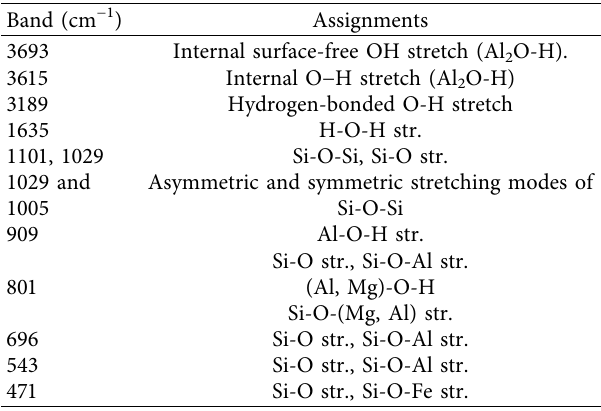
Figure 10: DRIFT spectra of dispersed phase of iron ore slime: (a) DPAD200, (b) DPHU8, and (c) Table 7: Important bands of clay minerals along with their possible assignments.